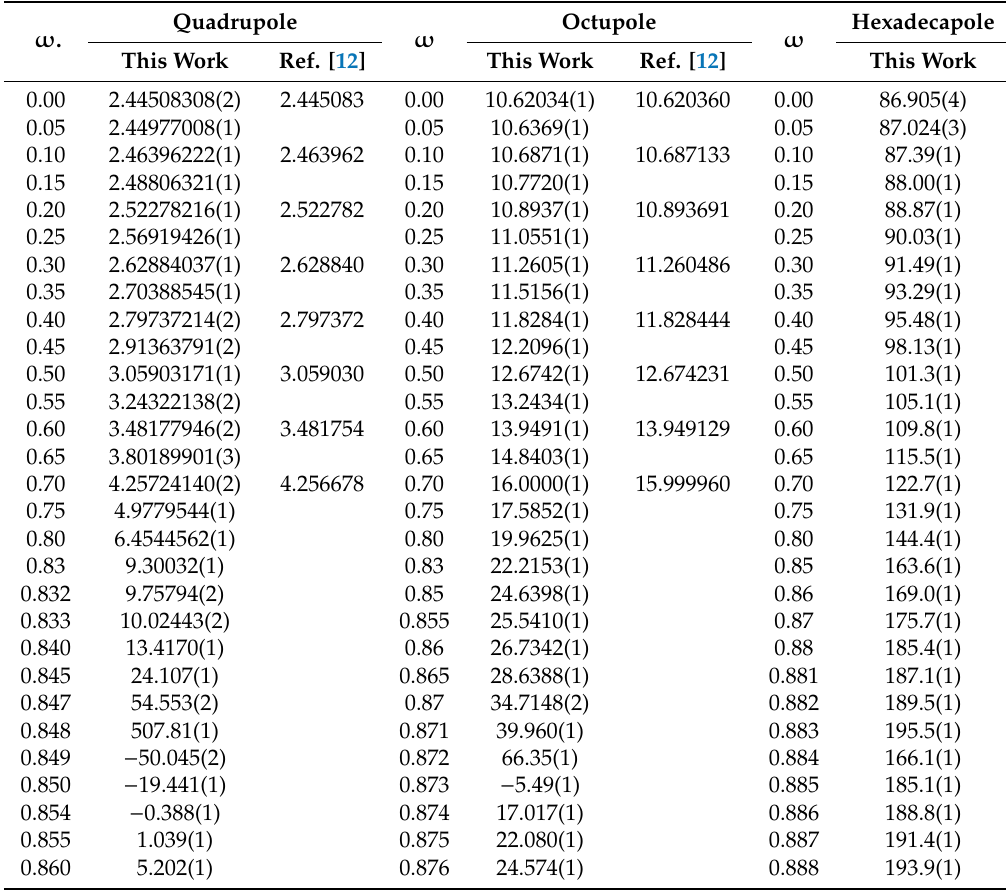
Table 1. The dynamic quadrupole, octupole and hexadecapole polarizabilities (in a.u.) of the helium atom for di ff erent frequencies. The numbers in the parentheses denote the uncertainty in the last quoted